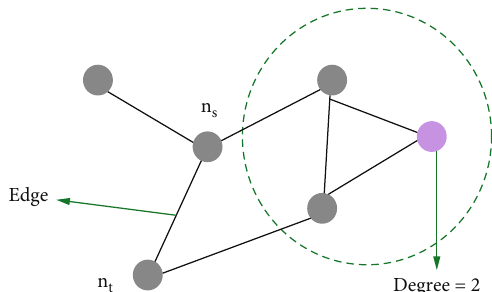
Figure 1: Schematic diagram of nodes and